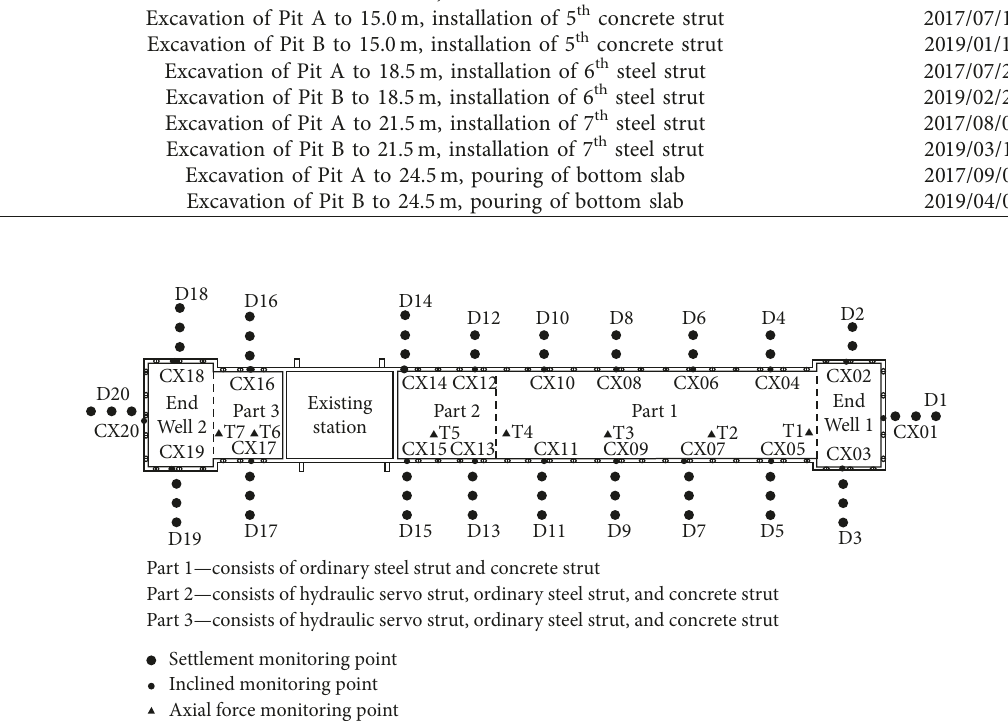
Figure 7: Layout of the monitoring